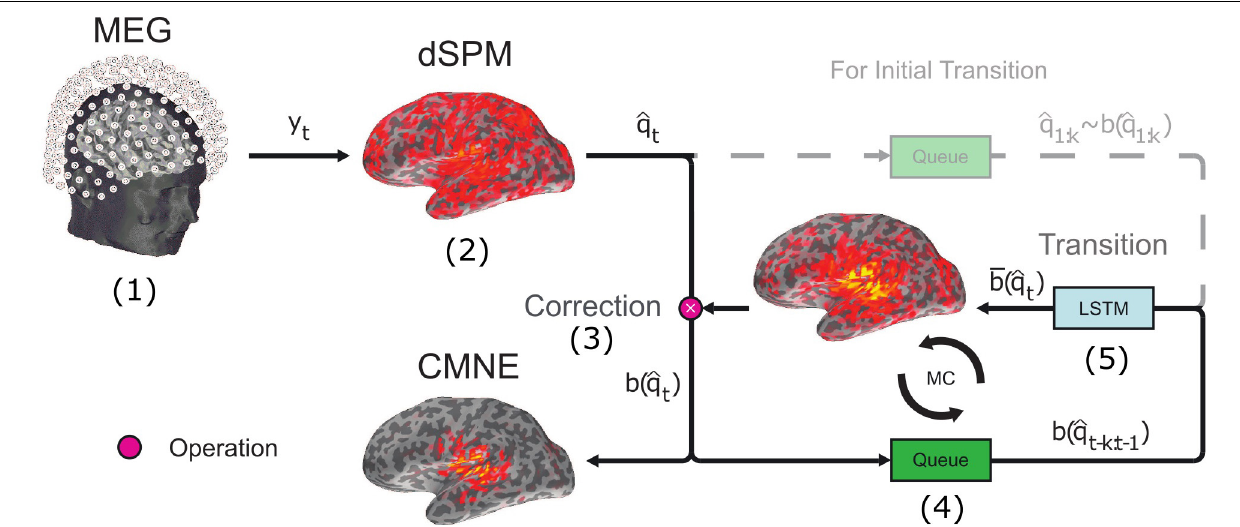
FIGURE 1 | Schematic illustration of CMNE outlining the major steps. (1) M/EEG data are measured, saved and processed as per standard protocol. (2) Based on the measurement data y t , a source estimate ˆ q t is found by dSPM. (3) The dSPM source estimate ˆ q t is corrected by a prediction ¯ b (cid:0) ˆ q t (cid:1) of what the estimate is expected to be based upon previous activations. This prediction ¯ b (cid:0) ˆ q t (cid:1) is found by an LSTM network (explained in step 5). The correction is an elementwise product ∗ of the source estimate ˆ q t and the prediction ¯ b (cid:0) ˆ q t (cid:1) , and the resulting product b (cid:0) ˆ q t (cid:1) is the CMNE estimate: b (cid:0) ˆ q t (cid:1) = ˆ q t ∗ ¯ b (cid:0) ˆ q t (cid:1) . (4) The CMNE estimate b (cid:0) ˆ q t (cid:1) is put into a stack together with the k previous activations b (cid:0) ˆ q t − k : t (cid:1) . (5) This stack of previous CMNE estimates is given to the LSTM network to predict the next activation ¯ b (cid:0) ˆ